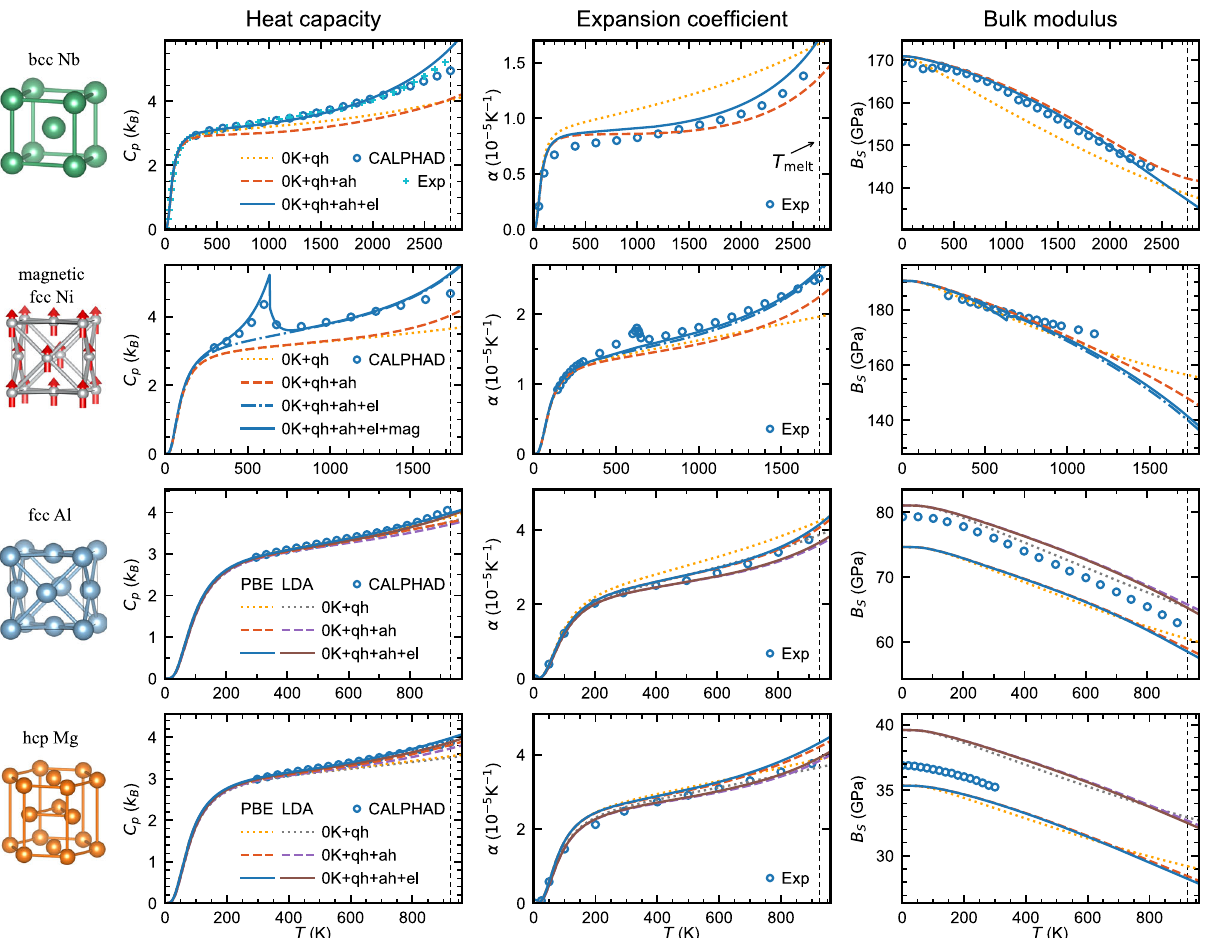
Fig. 6 Ab initio calculated C p ( T ), α ( T ), and B S ( T ) up to the melting point for Nb, Ni, Al, and Mg. Calculations are compared to experimental results shown in blue circles. Results considering different excitation mechanisms (effective QH (qh), anharmonic (ah), electronic (el), and magnetic (mag)) are shown. Nb and Ni results are for PBE, while for Al and Mg LDA results are additionally shown. The following experimental values are used for comparison: Nb 41,53 – 55 , Ni 41,51,52 , Al 5,41,56 , and Mg 5,41,57